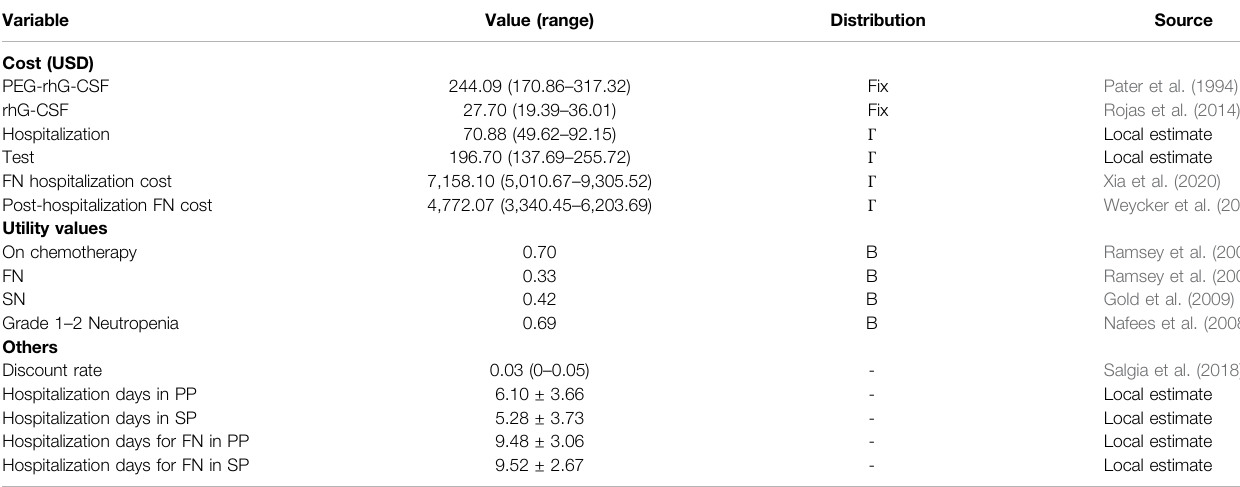
TABLE 1 | Model parameters and